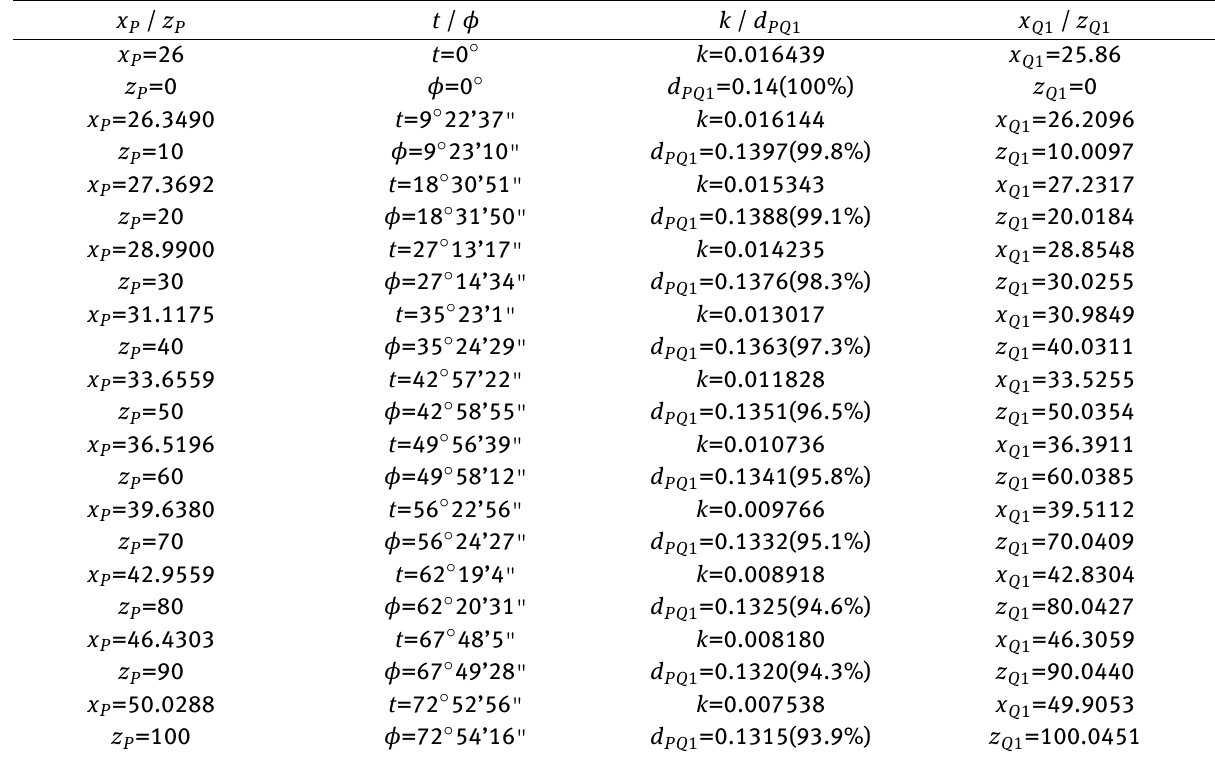
Table 1: Coordinates of points P and Q 1 , the angle t (for the point P ) and ϕ (for the point Q 1 ), coeflcient k and distance d PQ 1 measured at successive heights of the Rybnik